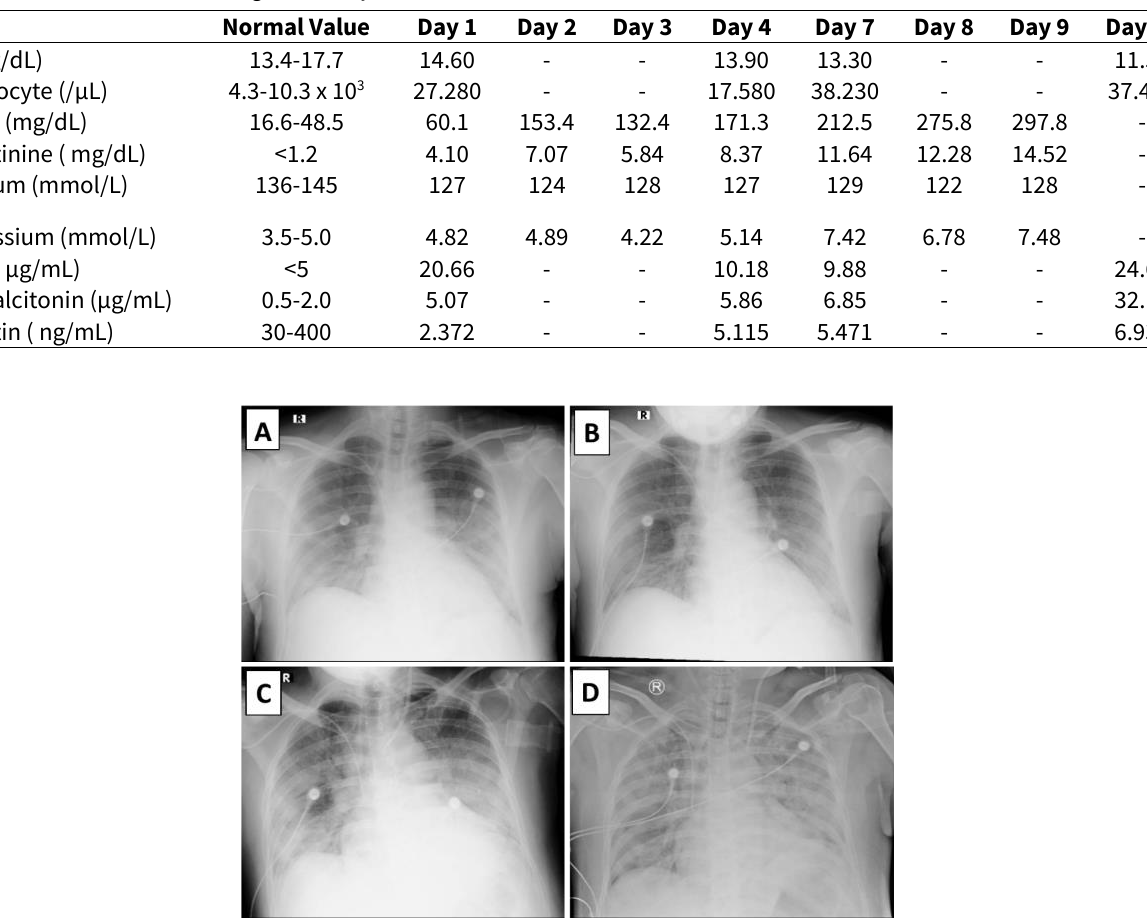
Figure 2. Development of Chest X-ray of Patient